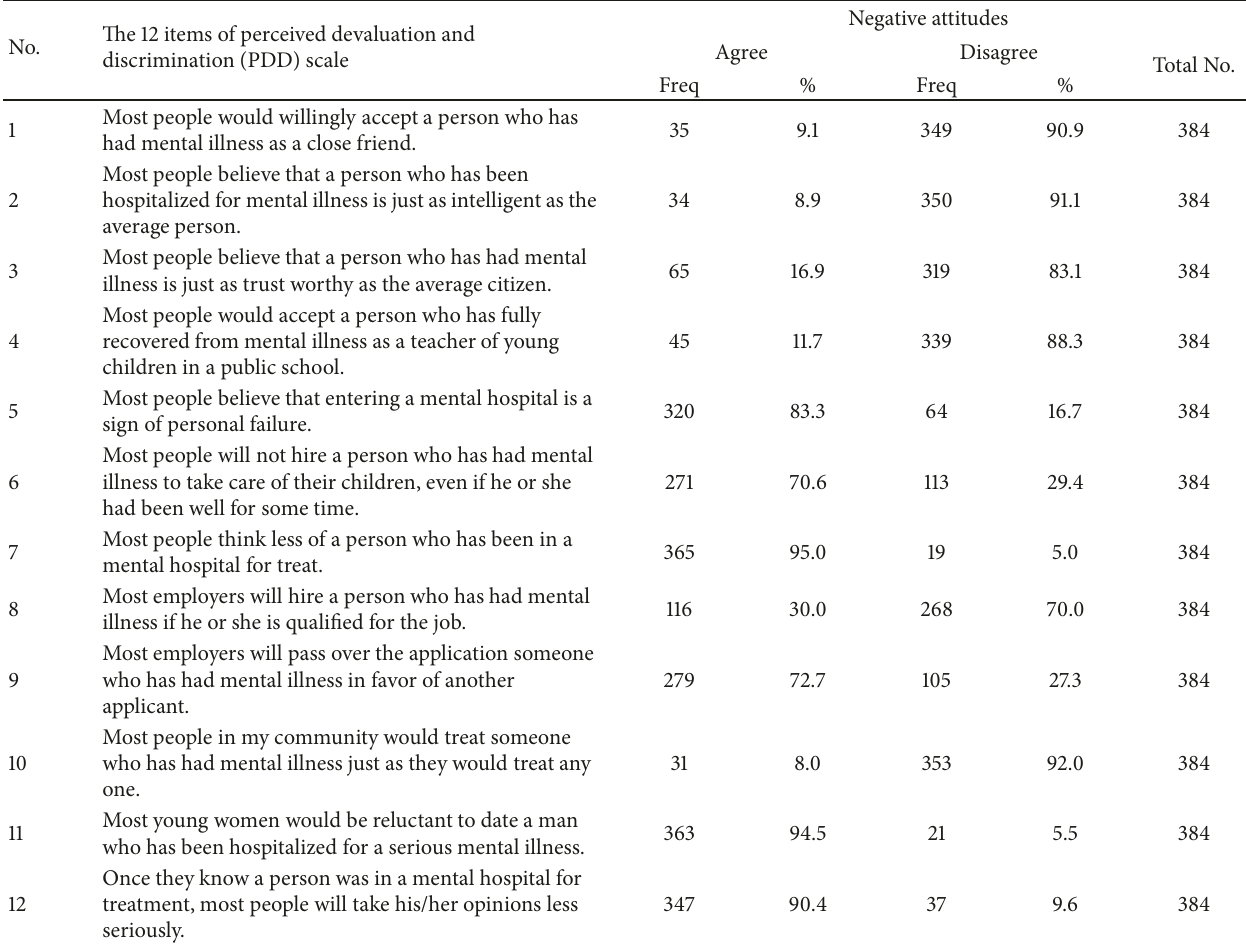
Table 2: Frequency of negative attitude of participants on the 12-item, 4-level Likert scale of the PDD scale at JUSH, 2012. The 12 items of perceived devaluation and No. discrimination (PDD) scale